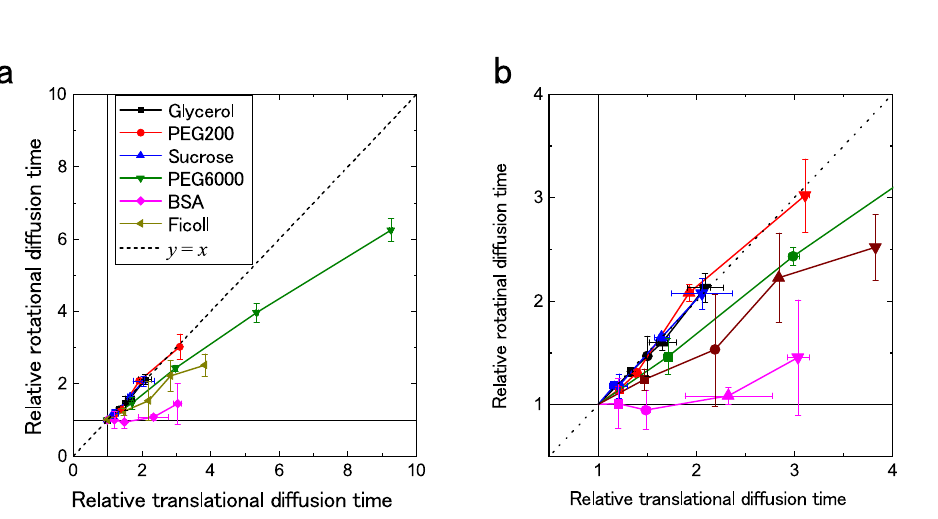
Figure 3. Comparison between the translational and rotational diffusion times normalized by these values of GFP solution in PBS. ( a ) Whole plot. ( b ) Enlarged plot. The error bars show standard deviations ( n = 3). Pol- FCS measurement for 30 s was repeated 10 times. The excitation laser power was 3.2 µW (1.6 kW/cm 2 ) at the samples. The concentrations of each sample at each data point are 0, 50, 100, 150, and 200 mg/mL in order from point (1, 1) for each